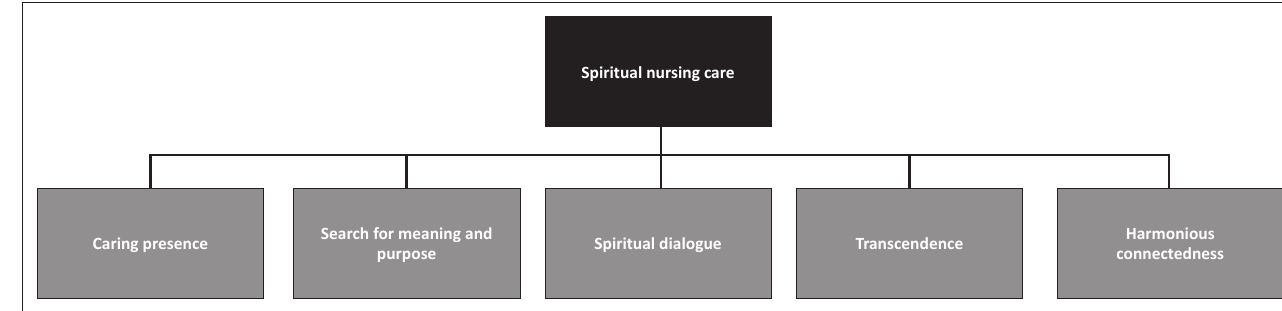
FIGURE 1: Defining attributes of spiritual nursing